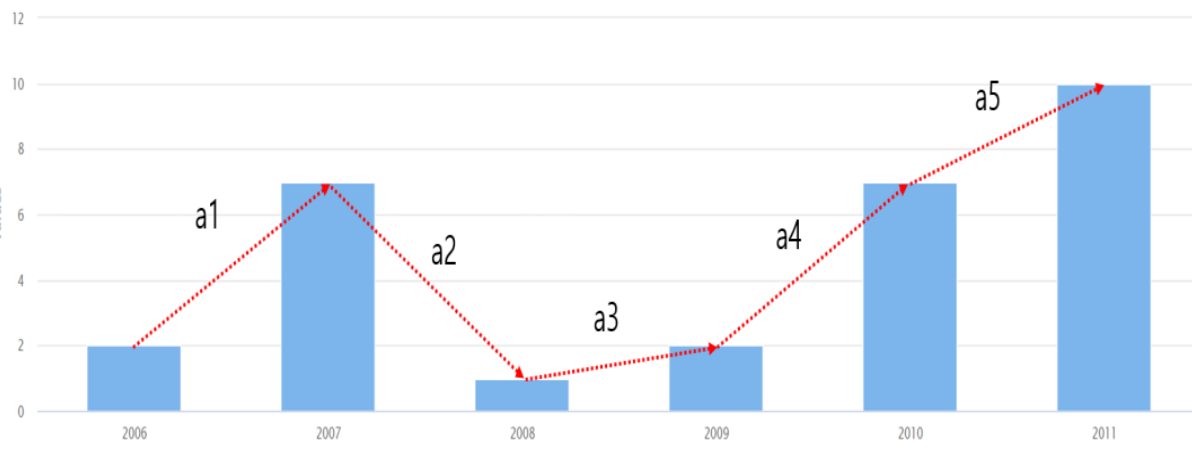
Figure 1. Example of average-based keyword novelty analysis. ( a ) Keyword occurrence frequency 1 ( b ) Keyword occurrence frequency 2.